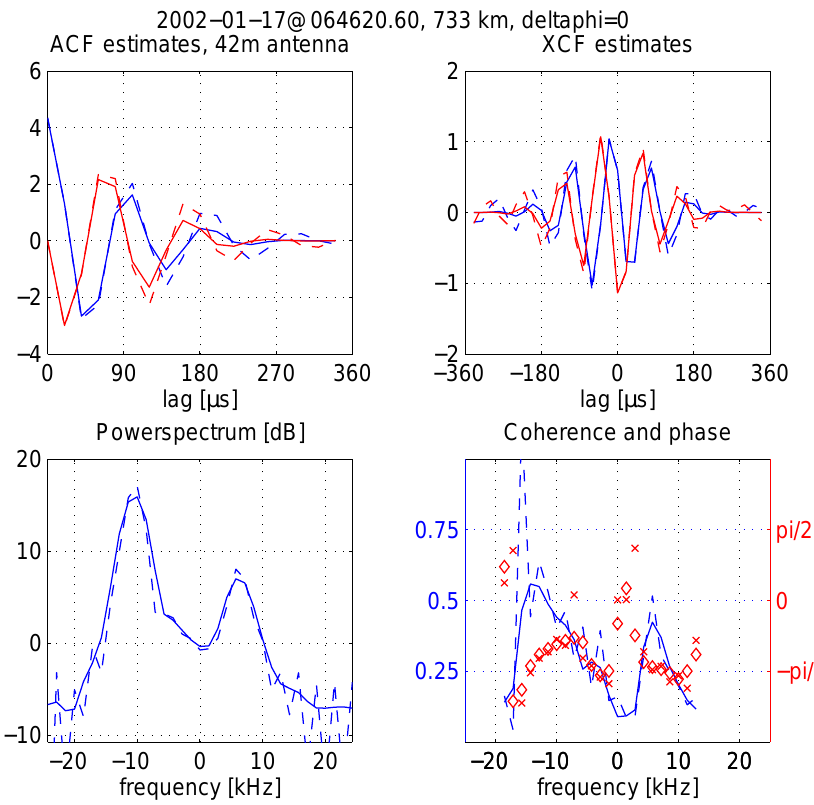
Fig. 4. The effects obtained using windowing on the correlation functions, these examples are from the 0 . 2s integration starting on 06:46:20.60 UT, for the range gate centered at 733km. The top two panels show correlation function estimates computed from the measure- ments, real parts in blue, imaginary parts in red. Broken lines are the original estimates, solid lines are after windowing has been applied. The top left panel shows the ACF estimate obtained with the 42m antenna, while the top right panel shows the XCF estimate. The bottom left panel shows the resulting powerspectra, using rectangular (broken line) and Hanning (solid line) windows, while the bottom right panel shows the resulting coherence (blue lines) and phase (red markers) for rectangular window (broken lines, crosses) and Hanning window (solid lines,